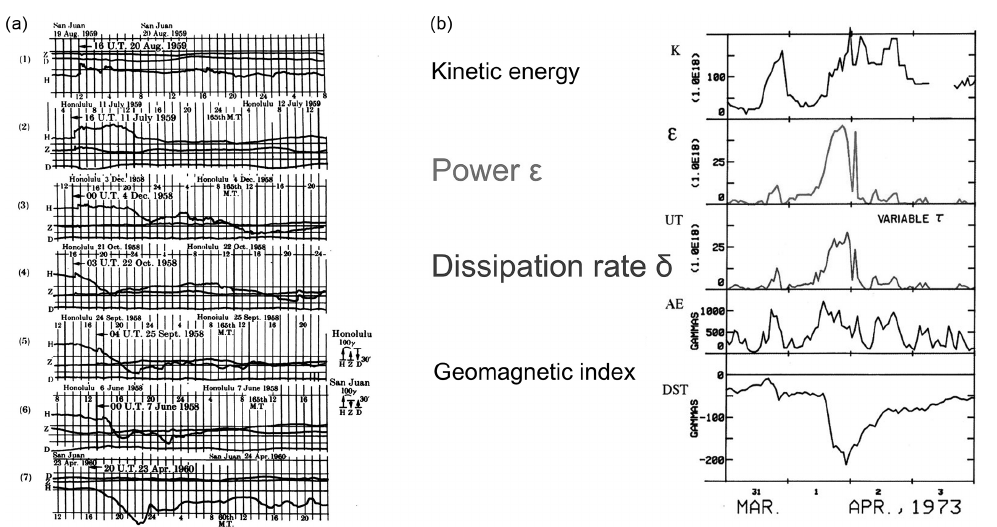
Figure 6. (a) Variety of the development of geomagnetic storms. (b) The relationship between ε and the total dissipation rate of the mag- netosphere is shown. It can be seen that there is no clear relationship between the kinetic energy of the solar wind and UT, because the IMF polar angle θ plays a crucial role. UT is determined on the basis of the two geomagnetic indices AE and D st .